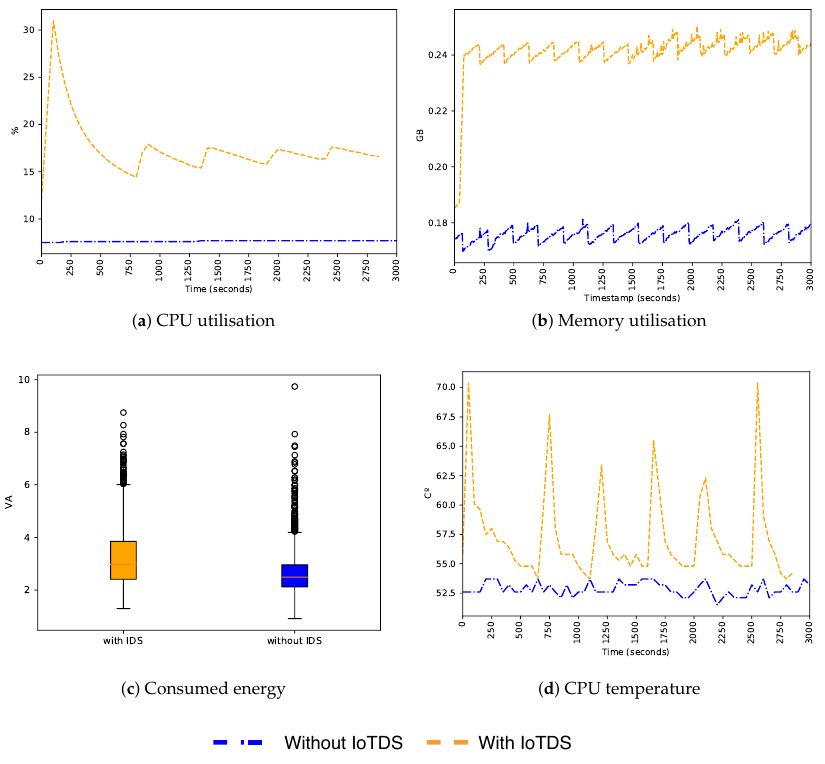
Figure 9. Behaviour of the ST profile regarding host’s resource usage with and without the IoTDS.